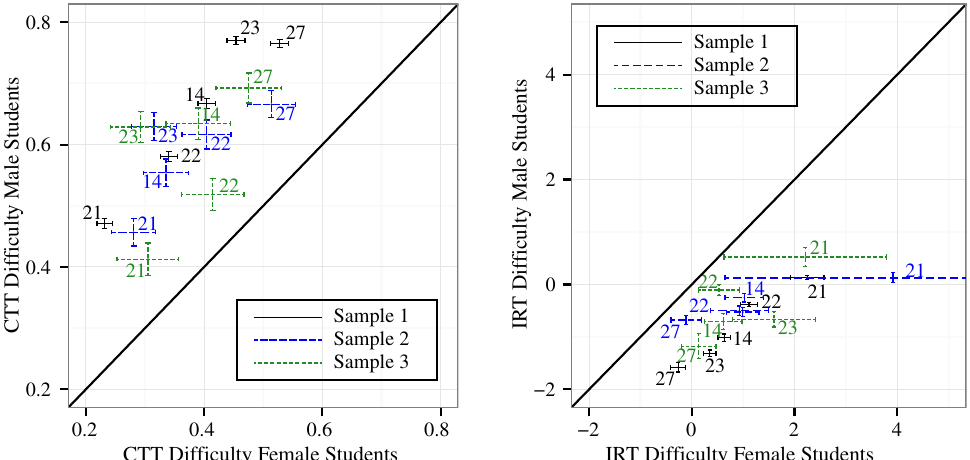
FIG. 3. CTTand IRT posttest difficulty scores for male and female students for problematic items from all samples. A line of slope one is drawn to allow comparison of male and female difficulty. The item number for each problem is also labeled. The IRT difficulty of Sample 2, item 23 is not labeled; the point overlays that of Sample 2, item